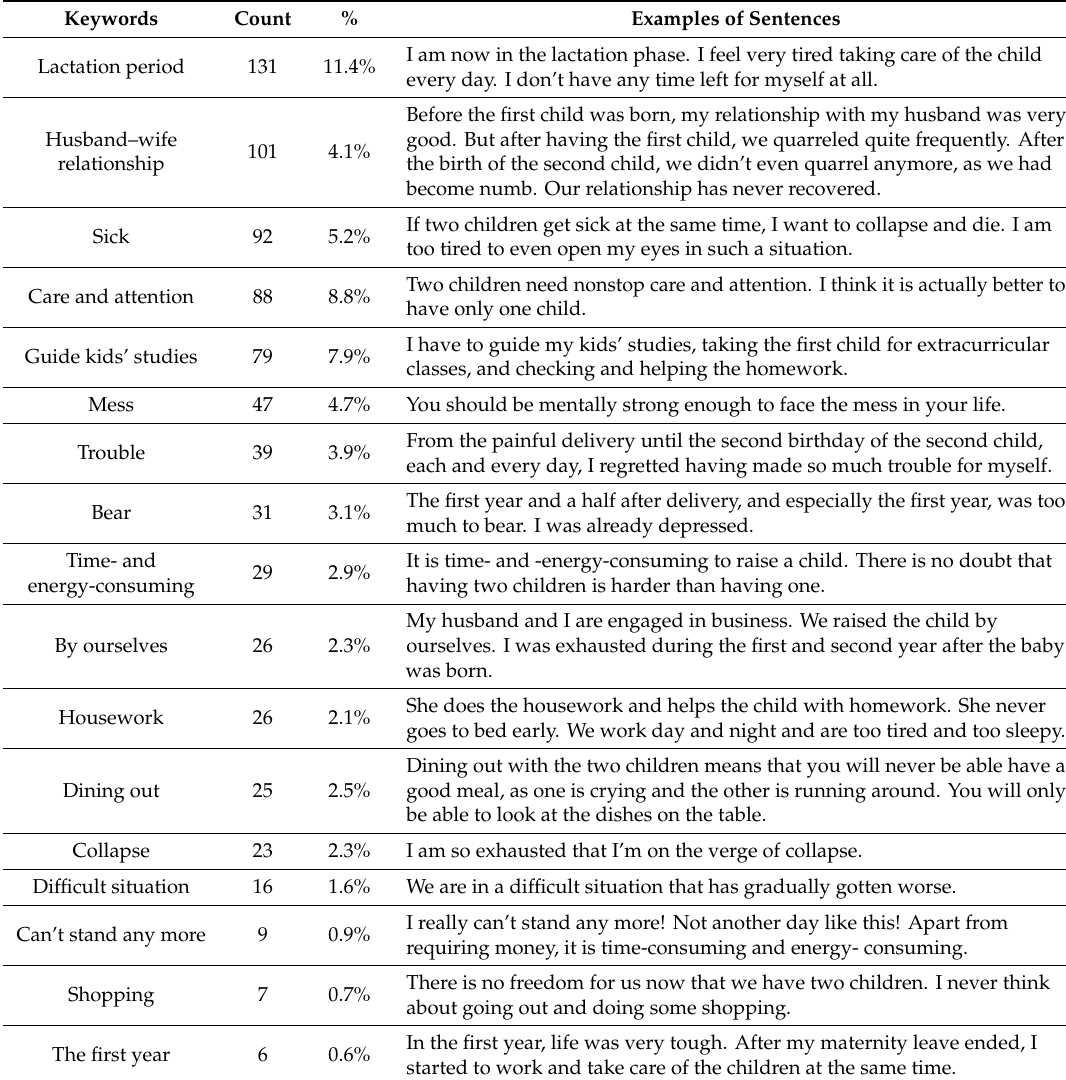
Table 5. Keywords indicating mental costs and sentence